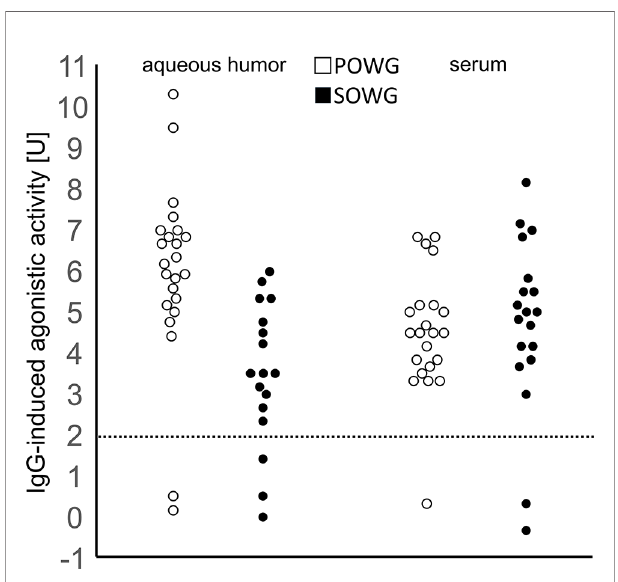
FIGURE 1 | Agonistic activity of b 2-agonistic autoantibodies.Stimulation of cardiomyocytes by sera or aqueous humor samples from patients with OAG. Open dots: POAG, fi lled dots: SOAG; normal range <2 units adrenergic activity. Statistics: all POAG against all SOAG p = 0.035; all AH against sera p = 0.96; POAG AH against sera p = 0.09; SOAG AH against sera p = 0.047; AH POAG against SOAG p = 0.003; sera POAG against SOAG p = 0.727.